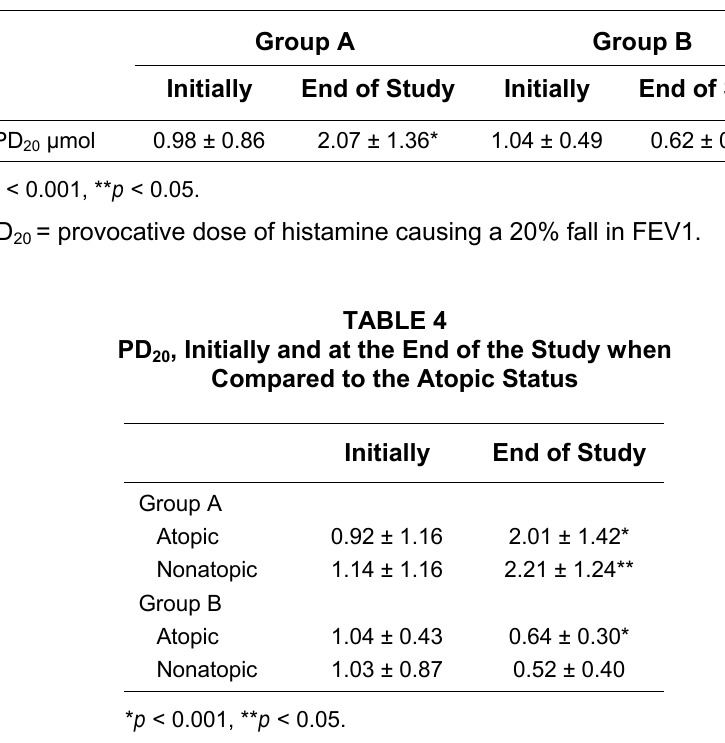
The Change in Daily Asthma Symptom Scores and the Use of Rescue Medication a